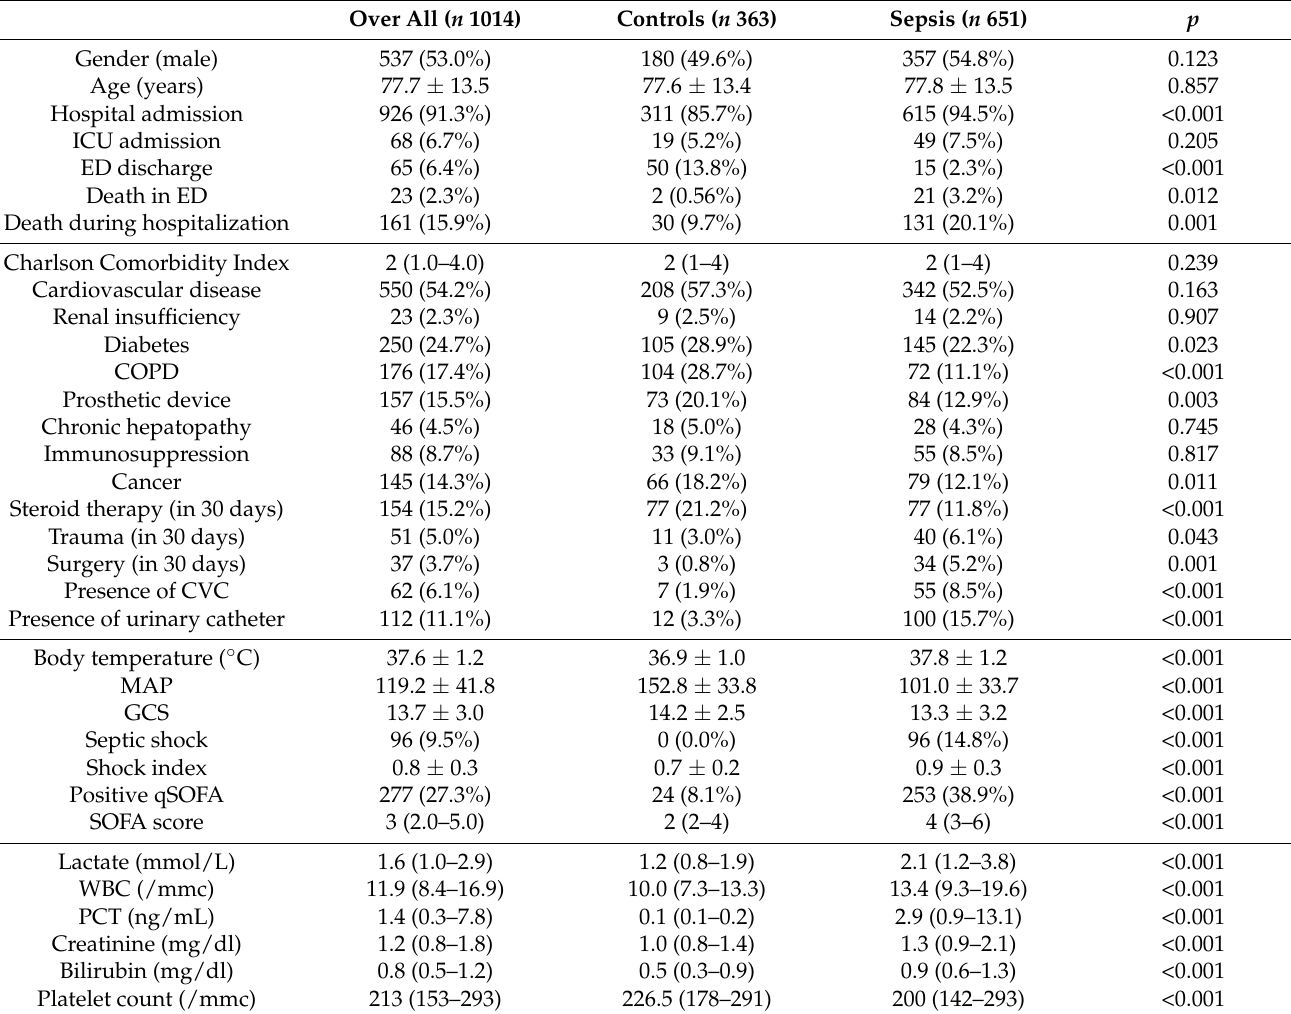
Table 1. Comparison between septic patients ( n 651) and controls ( n